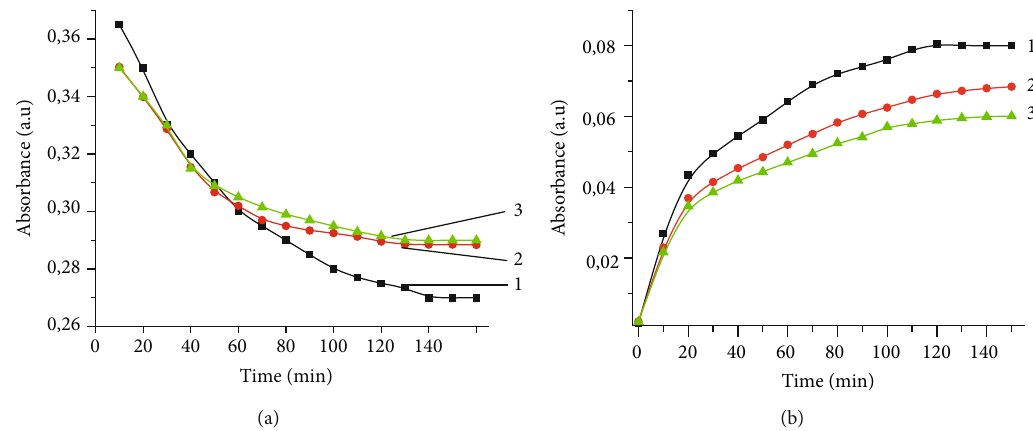
Figure 3: (a) The change in the absorption maximum of MB solution at λ 2: D20-PAA-0.4, and 3: D20-PAA-0.6; (b) the change in the absorption maximum of the methylene blue solution during dye di ff usion from the hydrogel: 1: D20-PAA-0.2, 2: D20-PAA-0.4, and 3: D20-PAA-0.6.